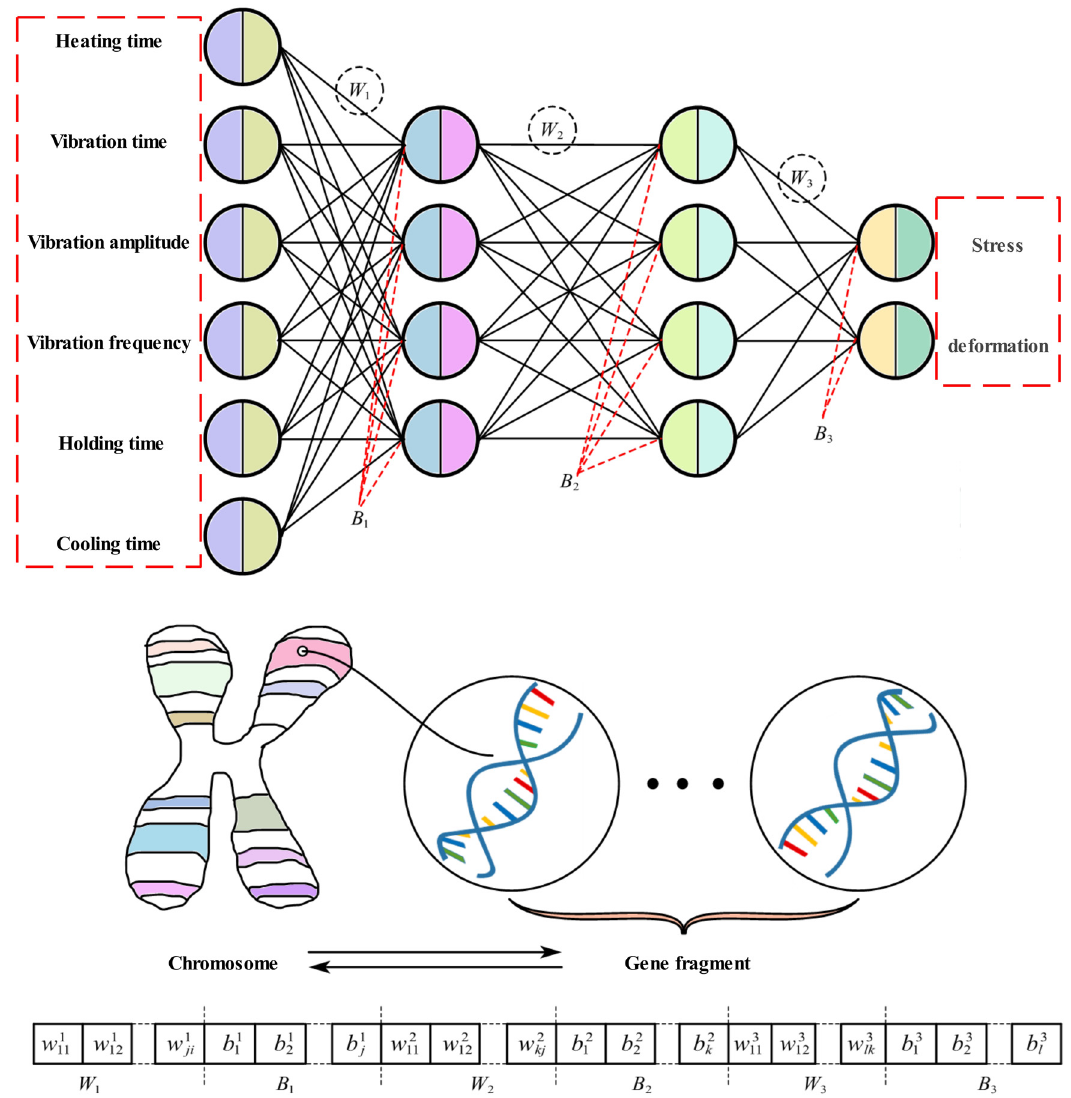
Figure 8: The structure of the TVSR e ff ect prediction model based on genetically optimized neural networks.